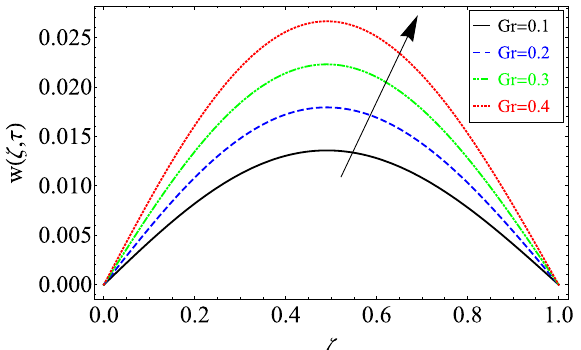
Figure 5. The effect of different values of Gr on velocity distribution of Maxwell nanofluid, when Re = 10 , α = 0.7 , τ = 0.5 , φ = 0.02 , Gm = 0.5 , Pr = 6300 , Sc = 15 and (cid:31) = 0.5 .